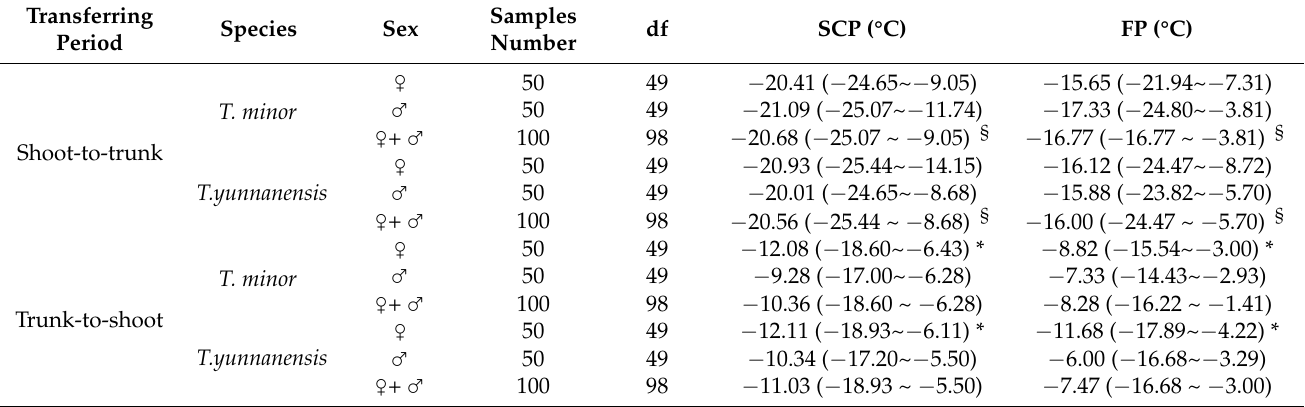
Table 1. SCP and FP of Tomicus minor and Tomicus yunnanensis at two